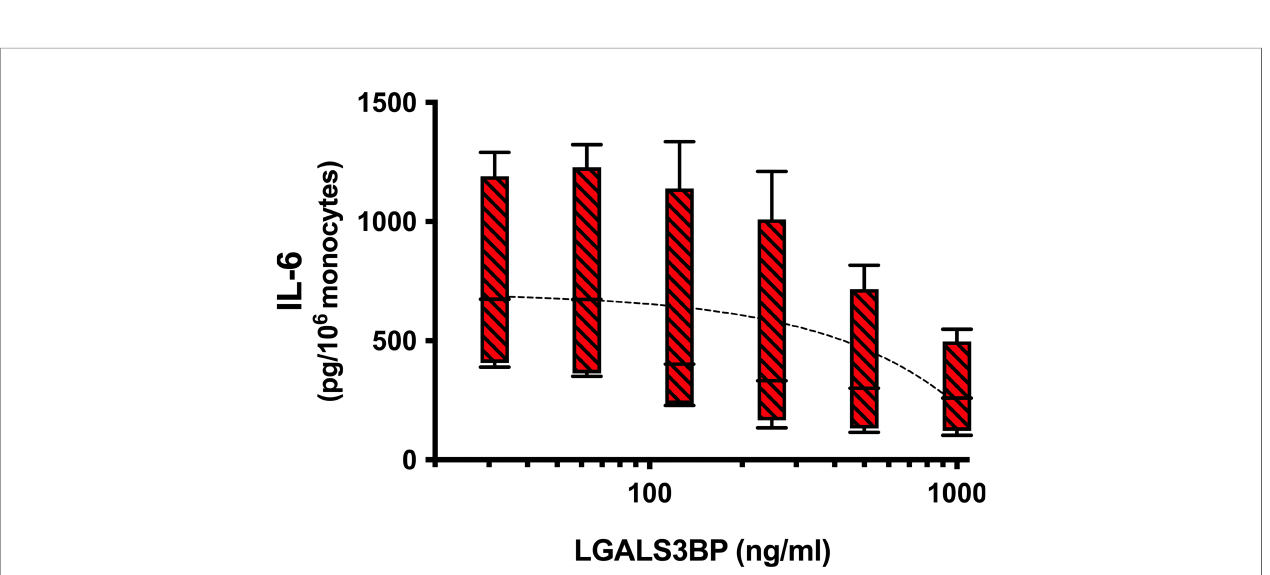
FIGURE 4 | Galectin-3 binding protein (LGALS3BP) suppresses IL-6 secretion by monocytes activated by the S1 subunit. Increasing concentrations of LGALS3BP were added to wells pre-coated with the S1 subunit, as described in the Materials & Methods . After incubating, plate wells were washed 3x to remove excess LGALS3BP before adding monocytes and IL-3 for cell culture. Supernatants were harvested after 20h incubation and assayed for IL-6 by ELISA. Box-Whisker plots represent results from different cell preparations (n = 4), with a linear regression line shown (P = 0.012). IL-6 levels induced by S1 alone without LGALS3BP averaged 713 ± 258 pg/10 6 monocytes (n =